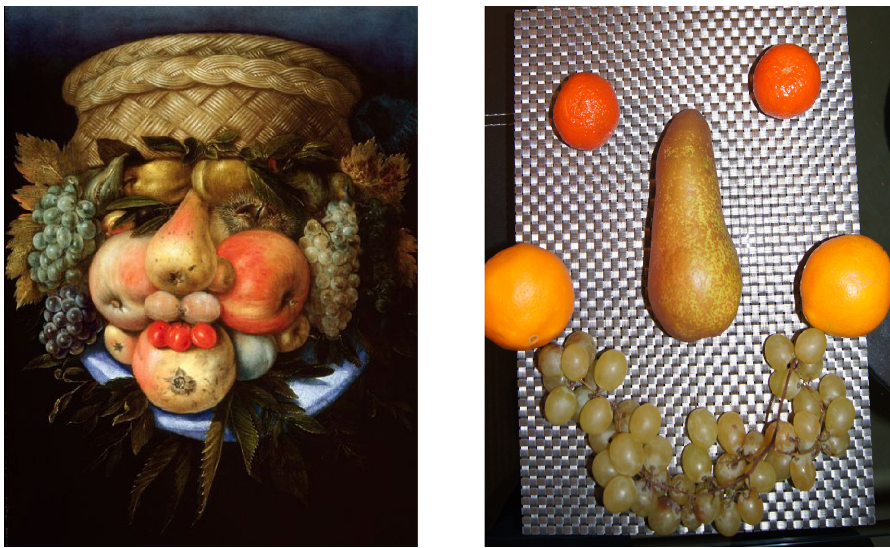
Fig 1. Examples of the Giuseppe Arcimboldo style. Left: “ Reversible Head with Basket of Fruit ” painting by Giuseppe Arcimboldo (1526 – 1593), an Italian painter best known for creating fascinating imaginative portraits composed entirely of fruits, vegetables, plants and flowers (image source Artdaily.org; public domain). Right: The portrait of one of the authors of this paper (ANS) created by another author (MAP) in a manner slightly bordering on the style of Giuseppe